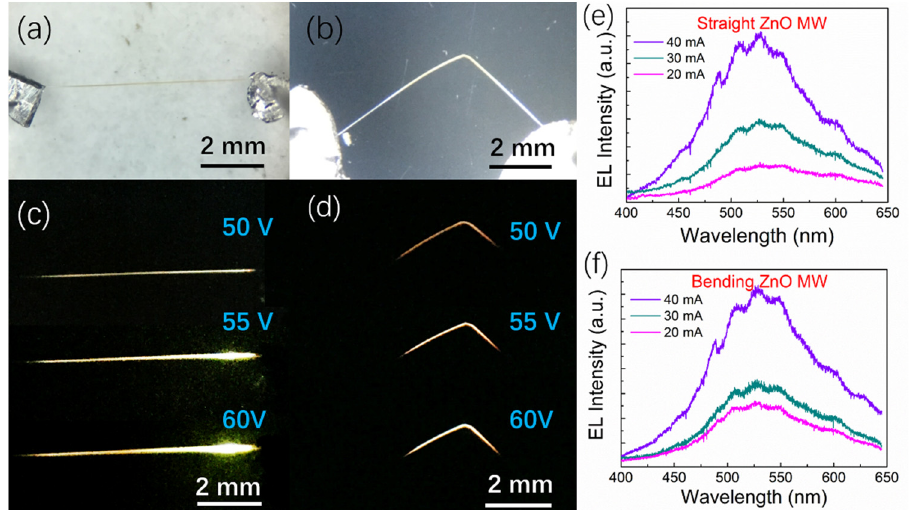
Figure 7. Electroluminescence performance of ZnO microwire. ( a , b ) Optical images of straight and bent ZnO microwires, ( c , d ) the corresponding emission images of straight and bent ZnO microwires captured by CCD camera, ( e , f ) electroluminescence spectrum of straight and bent ZnO microwires.